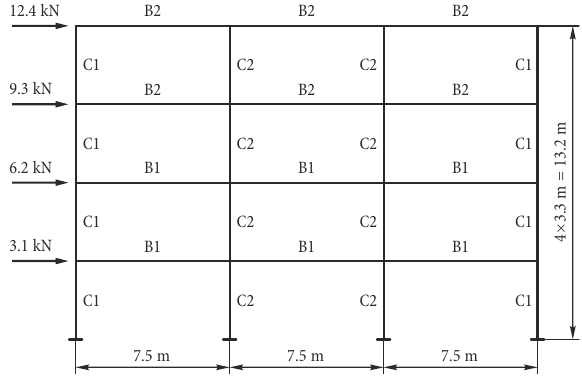
Fig. 2. Topology of the first model